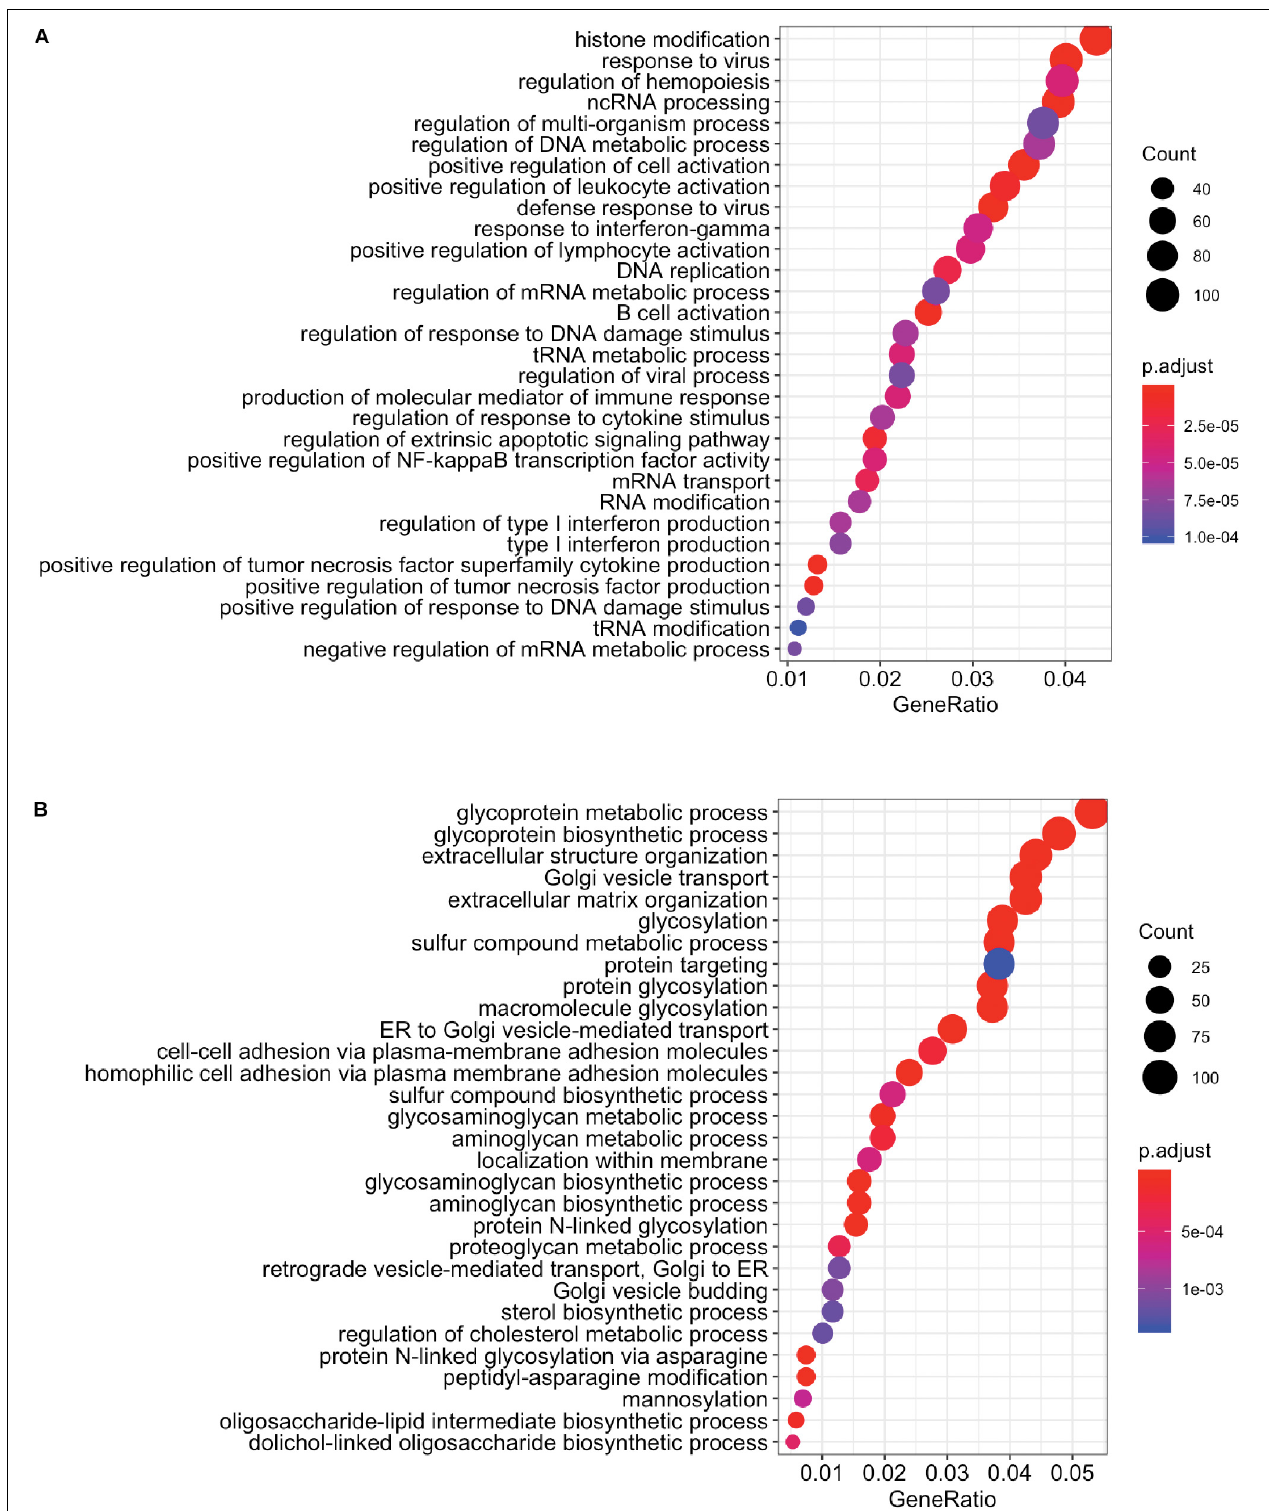
FIGURE 4 | GO term enrichment analysis by biological process. Enrichment analysis for (A) upregulated ( n = 3,227) and (B) downregulated ( n = 2,850) DEG in pattern 3 are presented ( p < 0.05). Terms are presented from highest to lowest combined score (a combination of the p -value and z -score) calculated as part of Enrichr